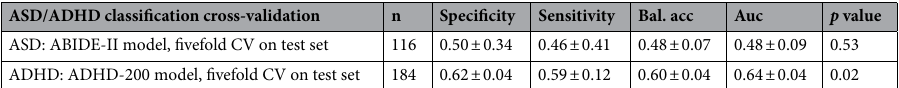
ASD/ADHD classification cross-validation n Specificity Sensitivity Bal. acc Auc p value ASD: ABIDE-II model, fivefold CV on test set